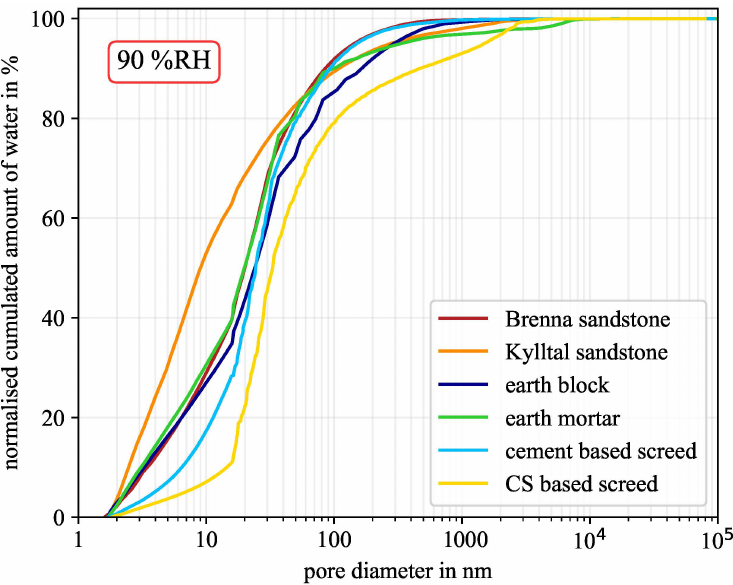
Figure 8. Normalised cumulated amount of water at 90% RH for the six material samples. (CS—calcium